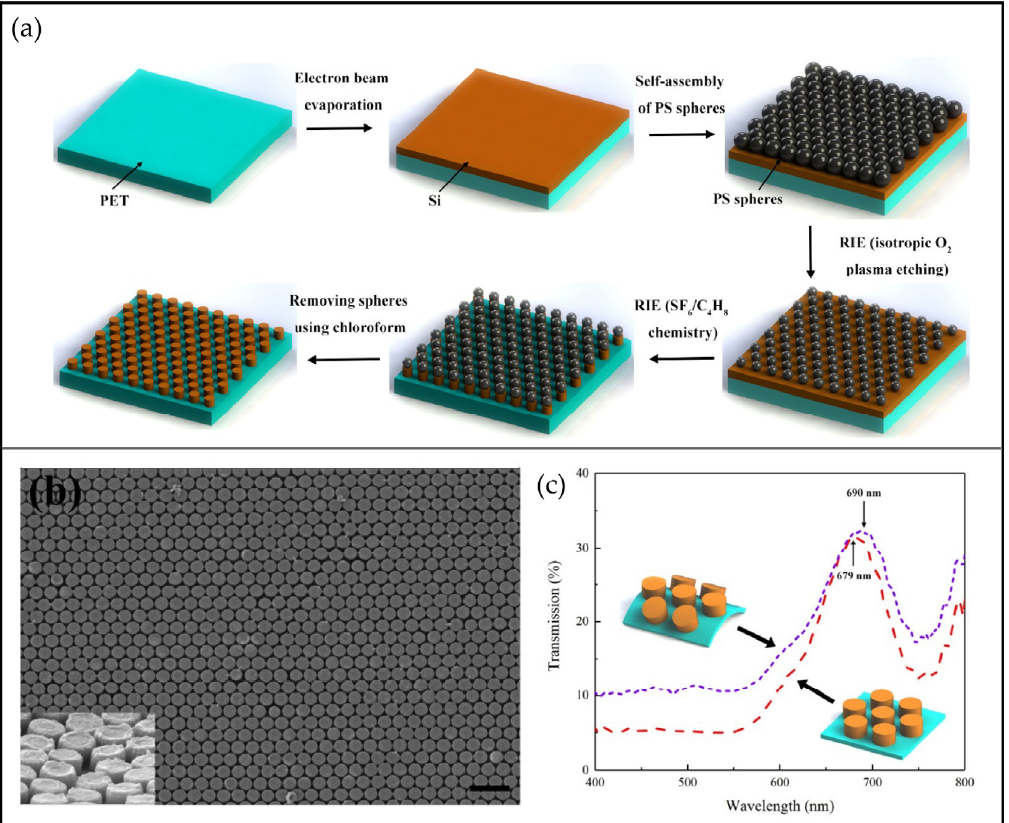
Figure 8. ( a ) The process of designing a flexible Si metasurface with a bottom-up approach and top-down approach; ( b ) The SEM of the flexible Si metasurface; ( c ) The transmission spectra of the metasurfaces with and without strain. Reprinted with permission from [119]. © The Optical Society.